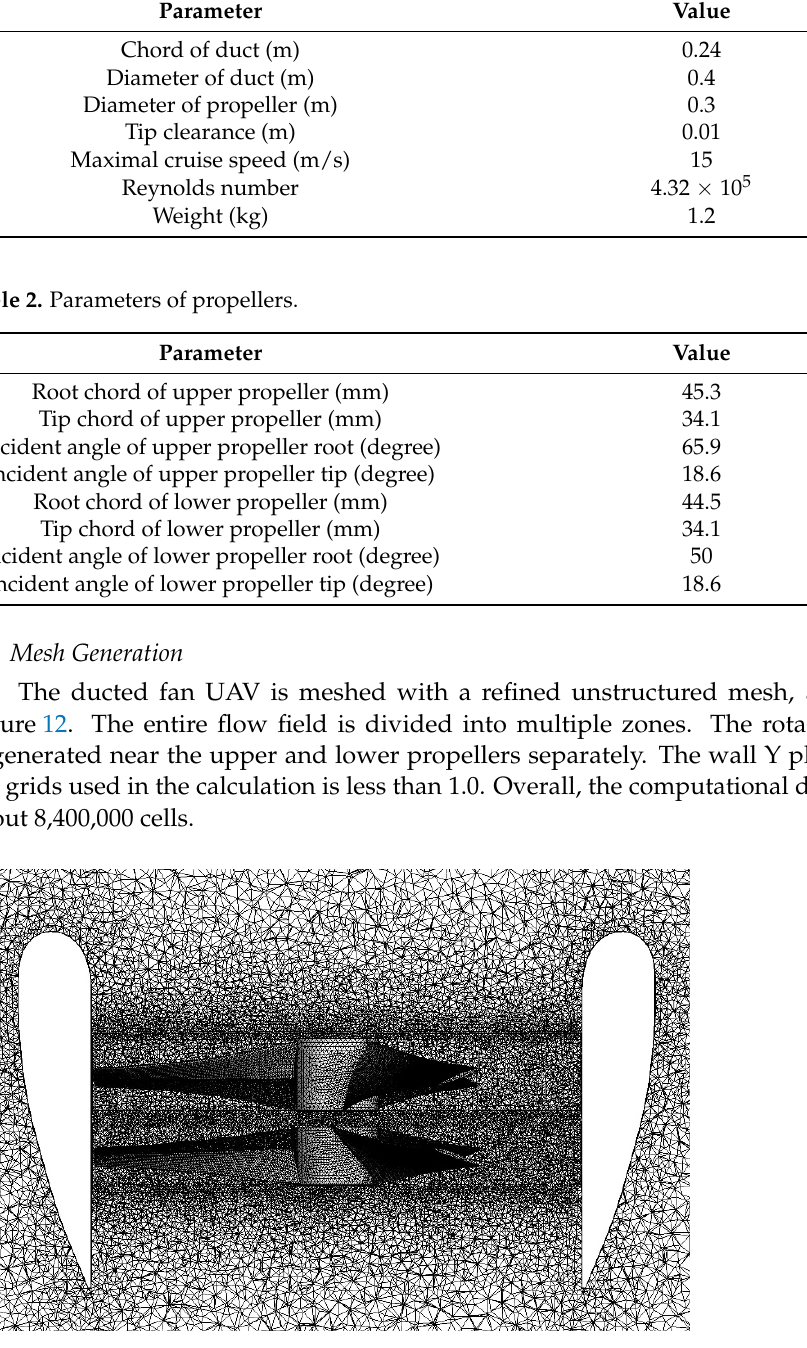
Figure 12. Computational grids of ducted fan